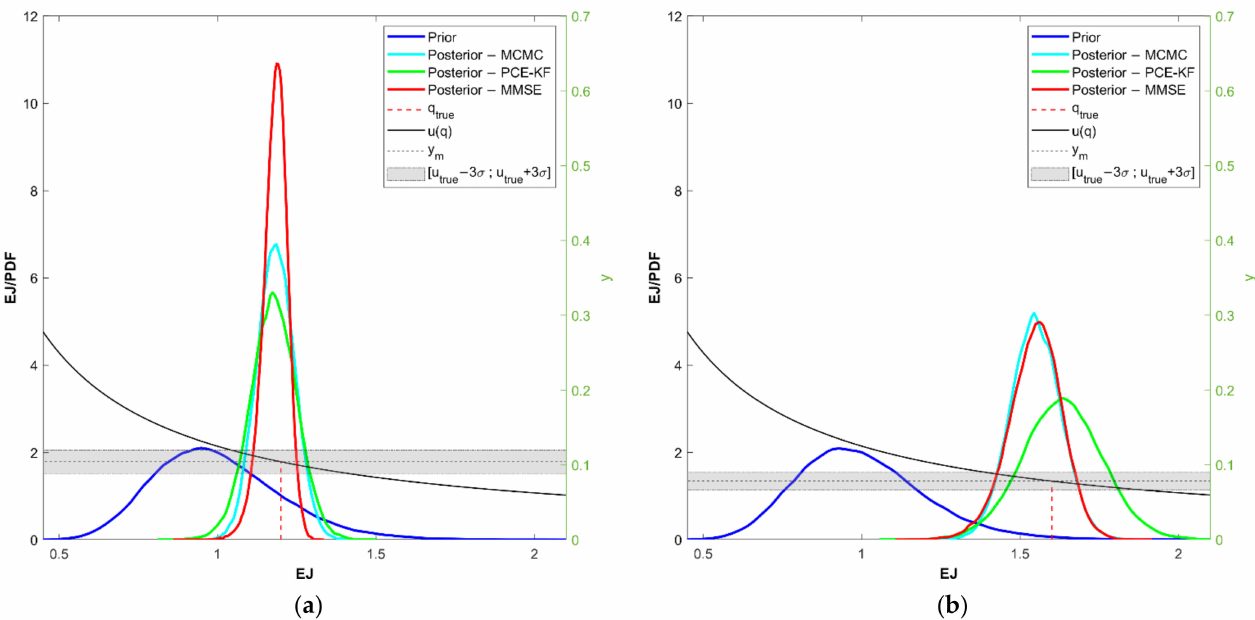
Figure 7. Comparison of updating procedures after mapping—cantilever beam: ( a ) EJ true = m + s = 1.2 and ( b ) EJ true = m + 3 s = 1.6. In each figure, the following are reported: the prior PDF (in blue); the posterior PDFs obtained via MCMC (in cyan), via PCE-KF (in green) and via NL-MMSE (red solid line); the true value of the parameter q true (red dashed line); the model response u ( q ) (black solid line); the measurement y m (black dashed line); the ± 3 σ ε region of the measurement (grey area).